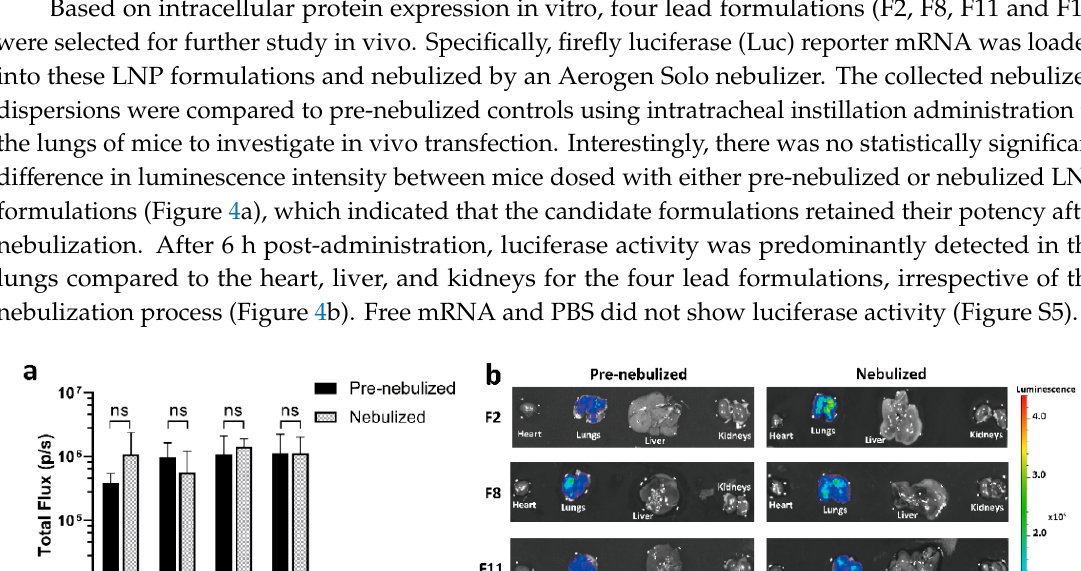
Figure 3 . In vitro intracellular protein expression in terms of percent GFP expression and fluorescence intensity of LNP formulations before and after nebulization in HEK-293 ( a , c ) and NuLi-1 cells ( b , d ). Figure 3a,b represent the percent GFP expression in HEK-293 and NuLi-1 cells, respectively. Figure 3c,d represent the GFP fluorescence intensity in HEK-293 and NuLi-1 cells, respectively.